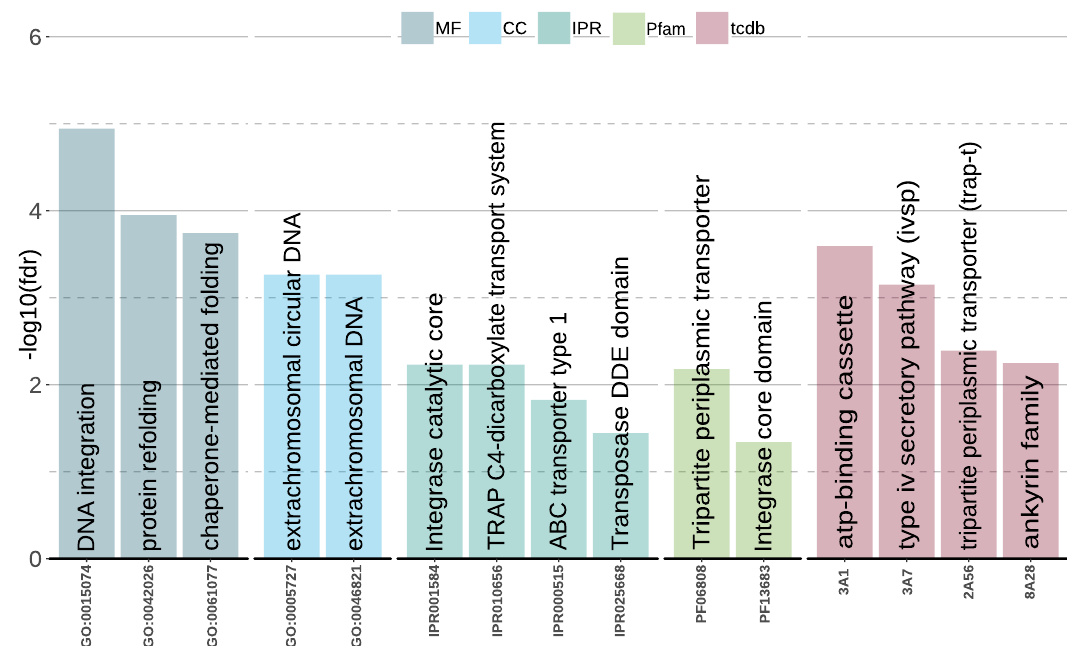
Figure 1. Graphical representation of the − log 10 ( fdr ) of the enriched categories in CAZY (Carbohydrate-Active Enzyme Database), Gene Ontology (GO), InterProScan (IPR), Protein Family (PFAM) and Transporter Classification Database (TCDB) in the set of A. salisburgensis -specific genes. Functional categories related to chitin degradation, protein folding, transport, and DNA integration are